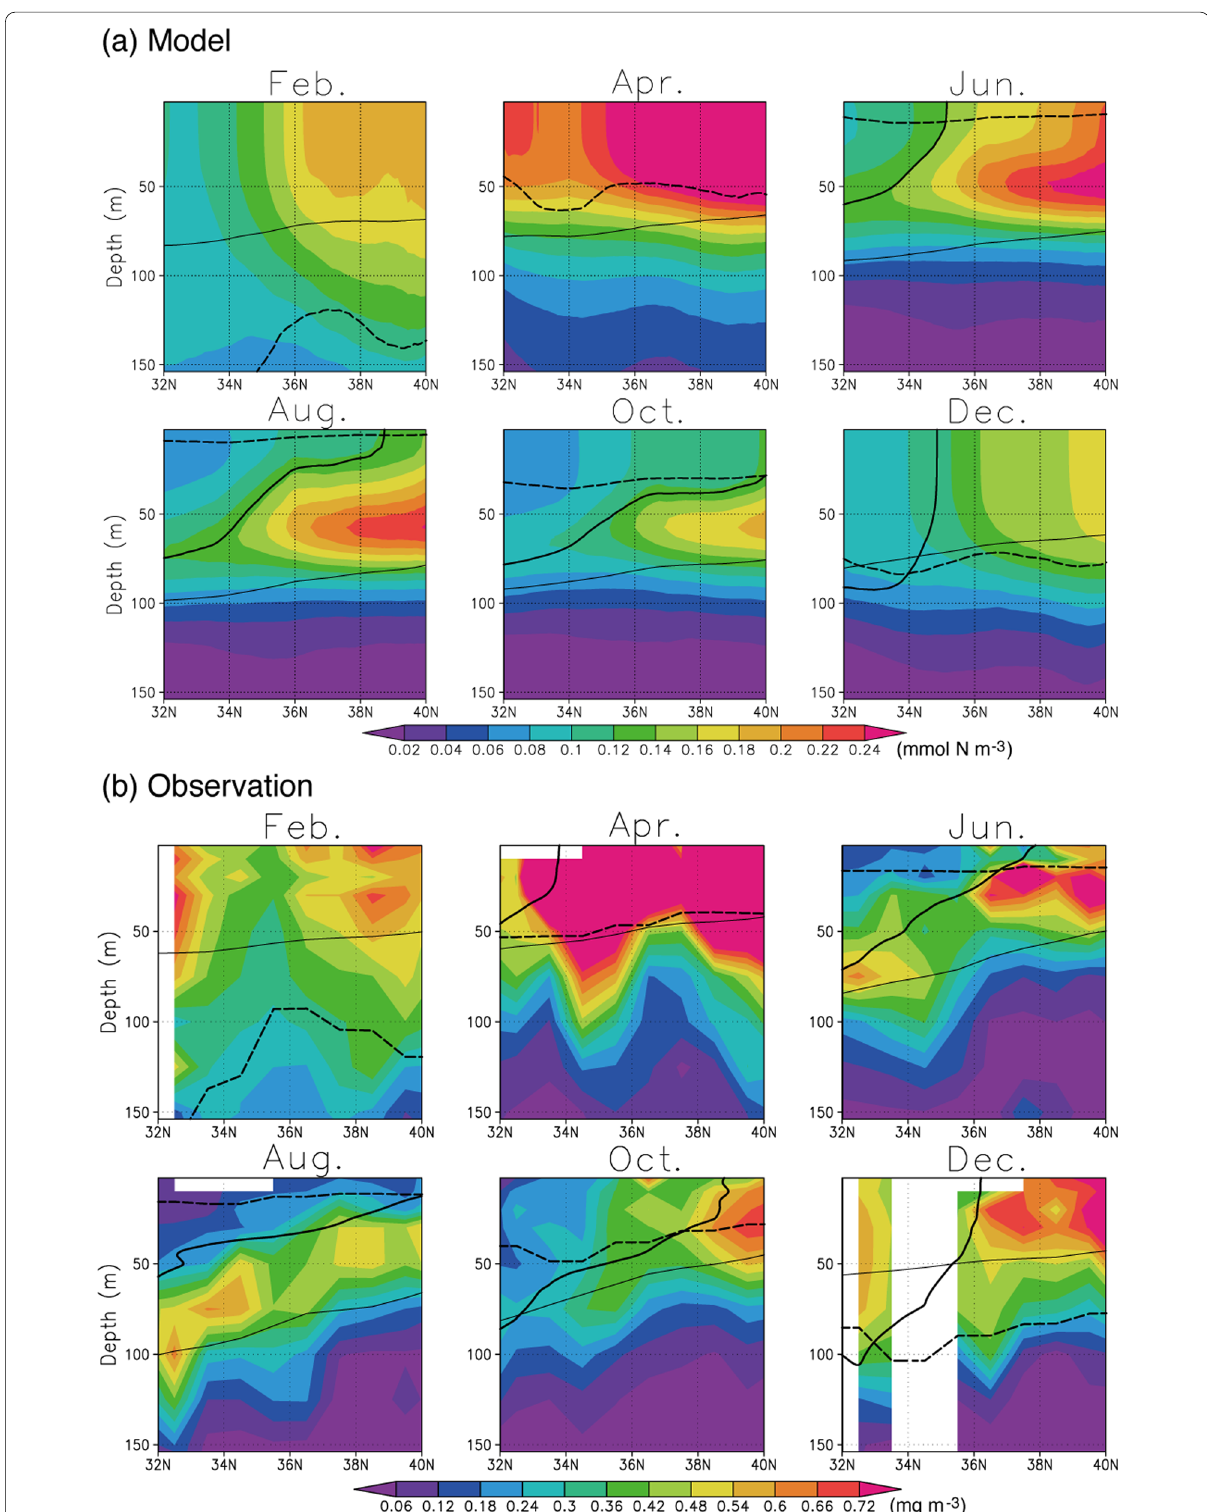
Fig. 2 Monthly climatology of phytoplankton concentration in the upstream Kuroshio Extension (KE) averaged between 142°E and 153°E for a OFES2 and b observation. The thick solid lines represent nutricline, the thick dashed lines represent the base of the mixed layer, and the thin solid lines represent the base of euphotic